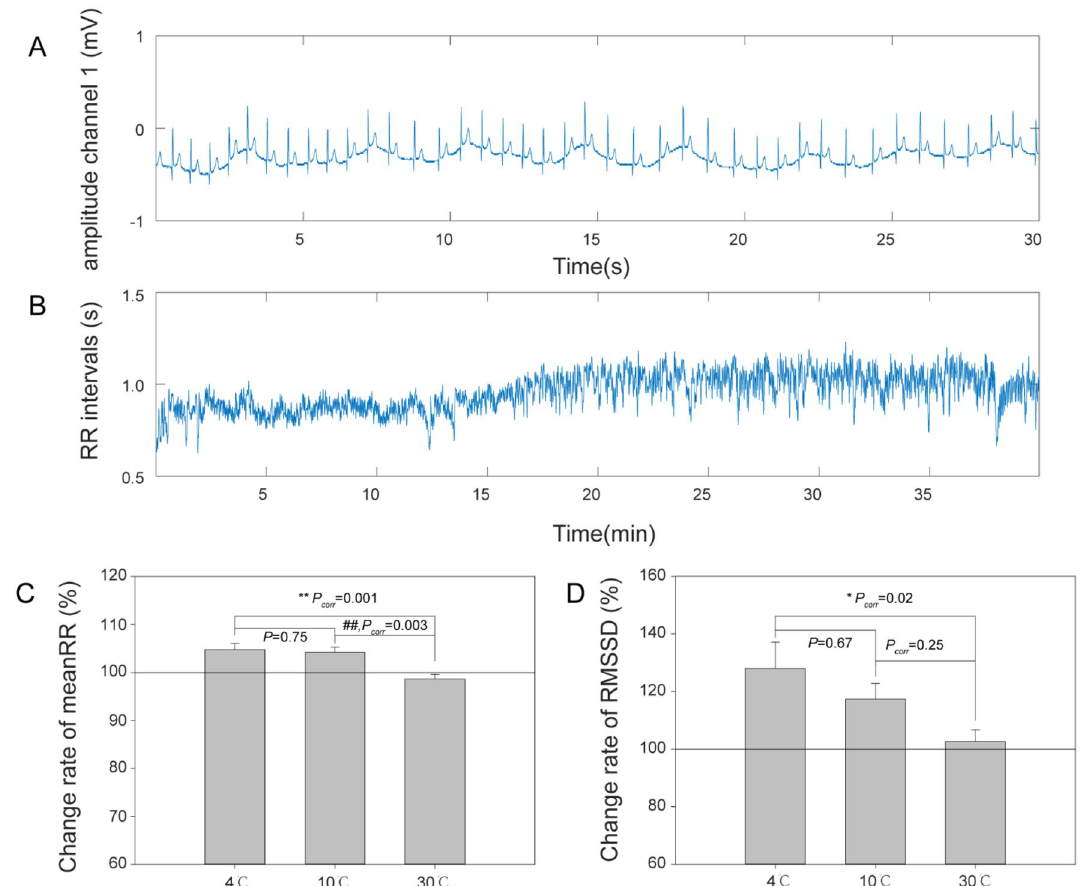
Figure 3. Change in HRV. ( A ) ECG signal from channel 1; ( B ) RR intervals of ECG; ( C ) Change rate of mean RR, F (2,57) = 8.73, P = 0.0005; ** P corr < 0.01; ## P corr < 0.01; ( D ) Change rate of RMSSD; F (2,57) = 3.75, P = 0.029; * P corr < 0.05; P corr : corrected P value. All values are reported as the mean ± standard error. ECG, electrocardiogram; RMSSD, root mean square of successive differences; HRV, heart rate